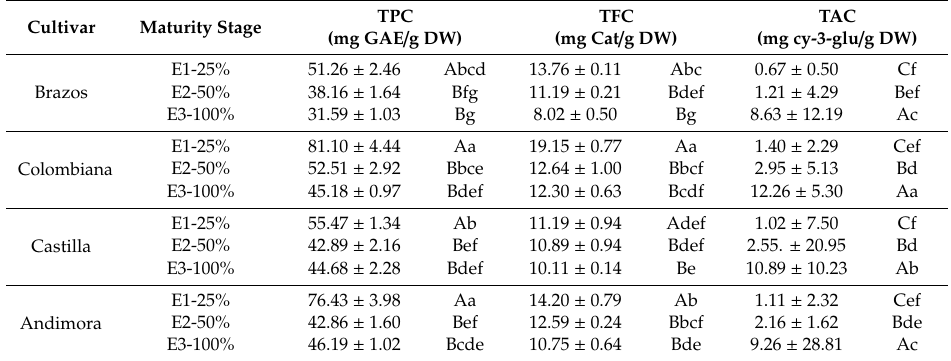
Table 3. E ff ect of maturity stage on total polyphenol content (TPC), total flavonoid content (TFC), and total anthocyanin content (TAC) of four blackberry cultivars of